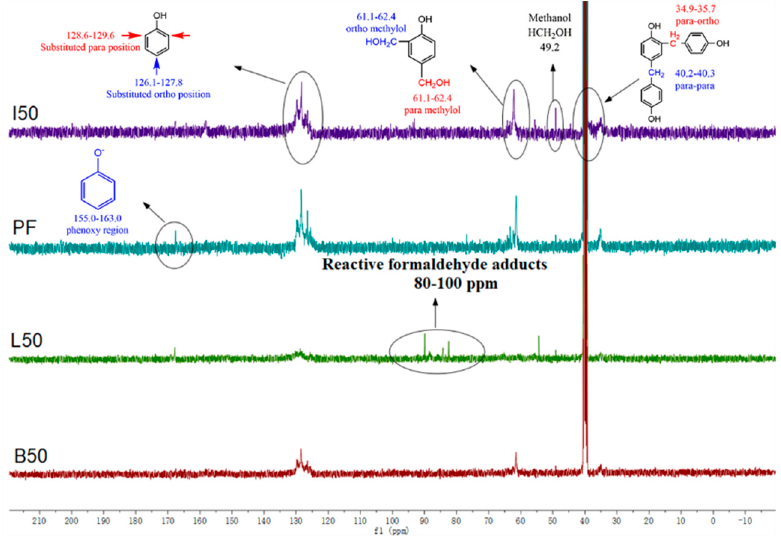
Figure 6. 13 C-NMR spectra of PF, ALPF(L50), and DLPF (I50, B50) resins with 50% lignin